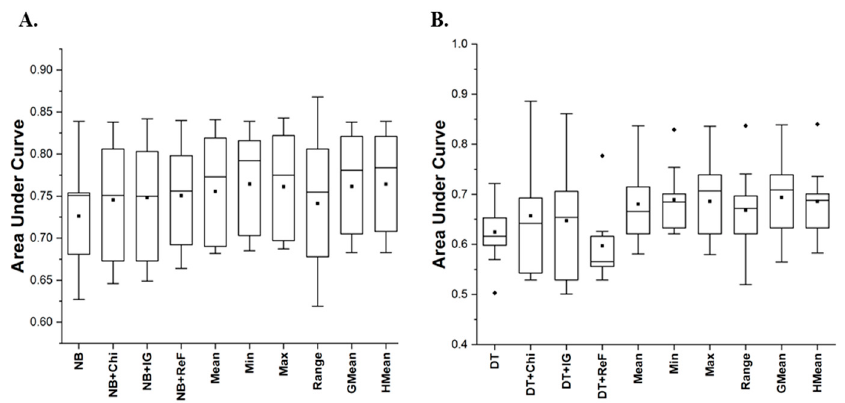
Figure 2. Box-plot representations (Accuracy values) of NB and DT classifiers with FS methods. ( A ) Average accuracy values of NB; ( B ) Average accuracy values of DT.